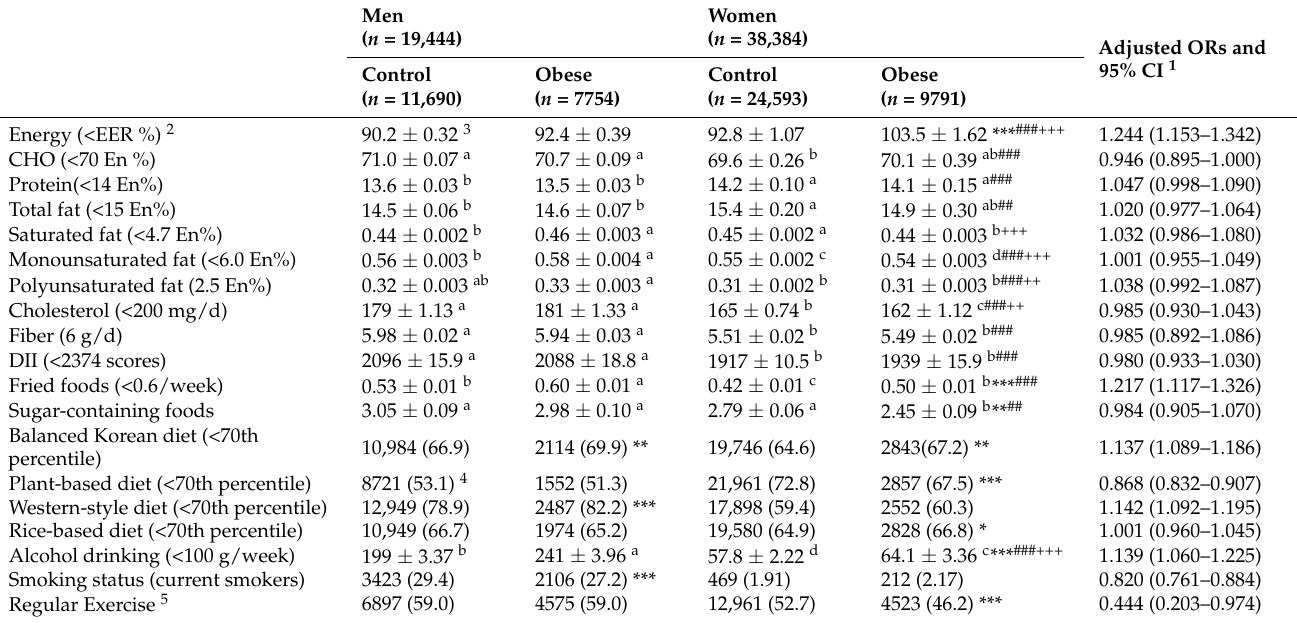
Table 2. Lifestyles including nutrient intake and association with obesity in the participants according to genders and obesity